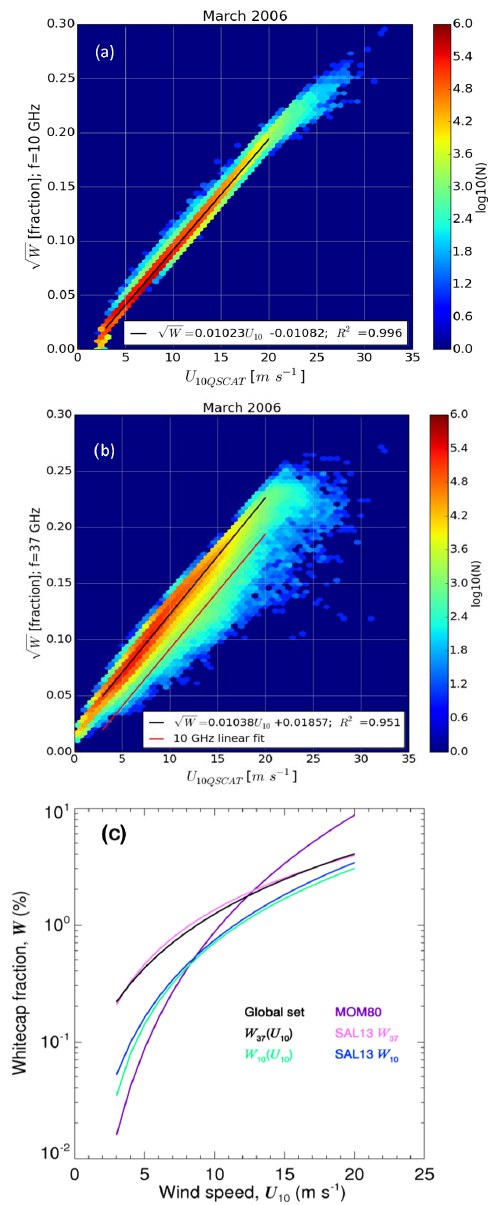
Figure 6. Wind speed dependence of whitecap fraction W(U 10 ) de- rived from the global W data set: (a) W 1 / 2 as a function of U 10 from QuikSCAT for March 2006, where W 1 / 2 is obtained with 10GHz measurement frequency; (b) same as in (a) but for 37GHz. The black line in both panels indicates the best linear fit through the data. The red line in (b) equals the black line in (a) . The col- ors indicate the amount of data points per hexbin. (c) Compari- son of derived global W(U 10 ) at 10GHz (green line) and 37GHz (black line) to W(U 10 ) parameterizations of Salisbury et al. (2013) in Eq. (1) for 10GHz (blue line) and 37GHz (magenta). Parameteri- zation W(U 10 ) of Monahan and O’Muircheartaigh (1980, MOM80) in Eq. (3) (purple line) is shown for